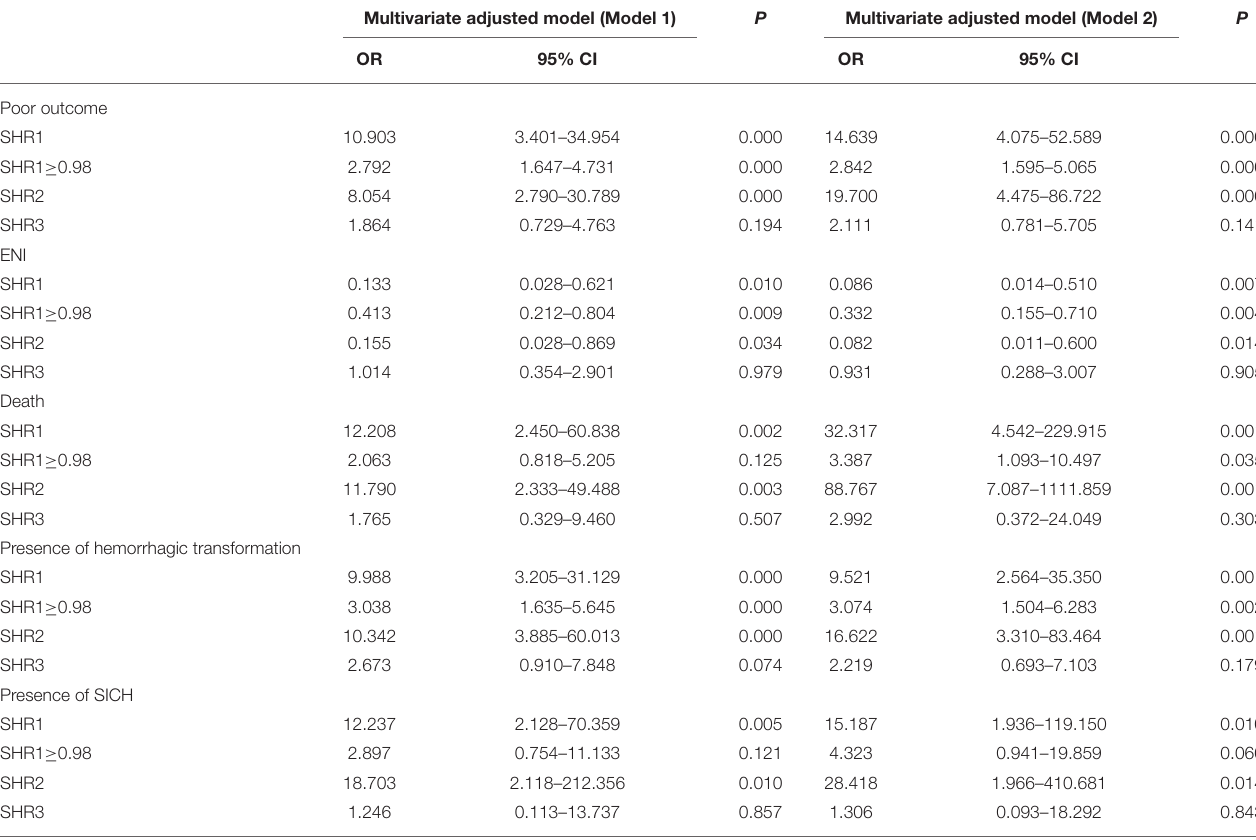
TABLE 4 | Multivariate logistic regression analysis of the associations between SHR and